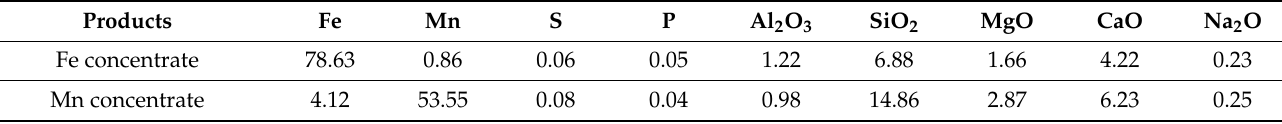
Table 5. Main chemical composition of iron concentrate and manganese concentrate (%).